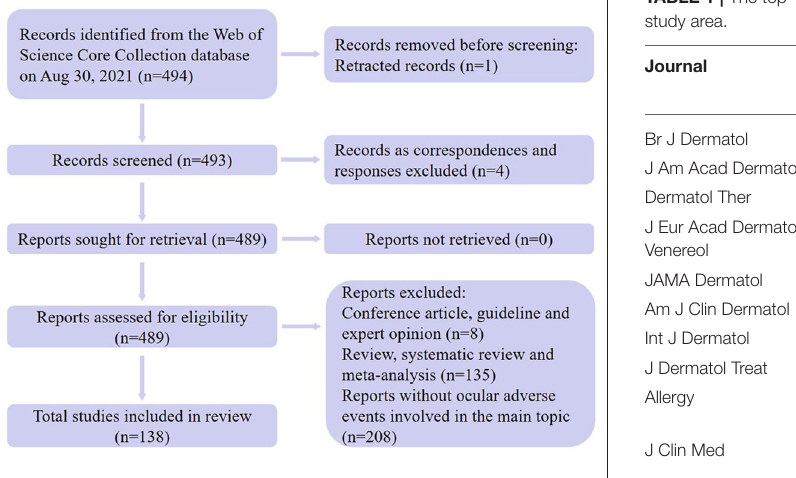
FIGURE 1 | The flow diagram of this study.